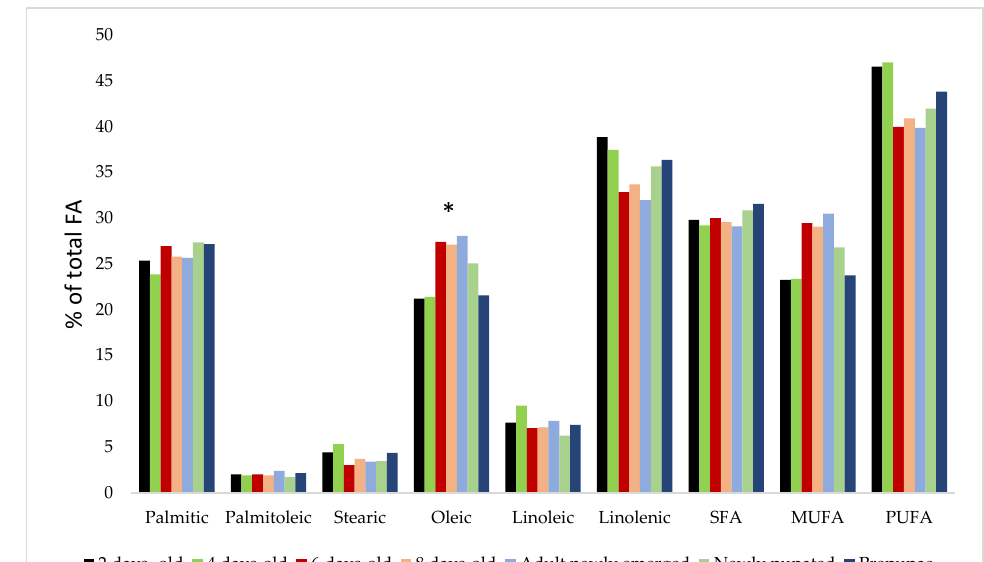
Figure 3. Average FA concentrations in SP depend on the stage of development, nonsignificant effect except for oleic FA, * p < 0.05 significant difference between means for oleic FA. The other FAs identified did not differ significantly when the stage of development was considered.